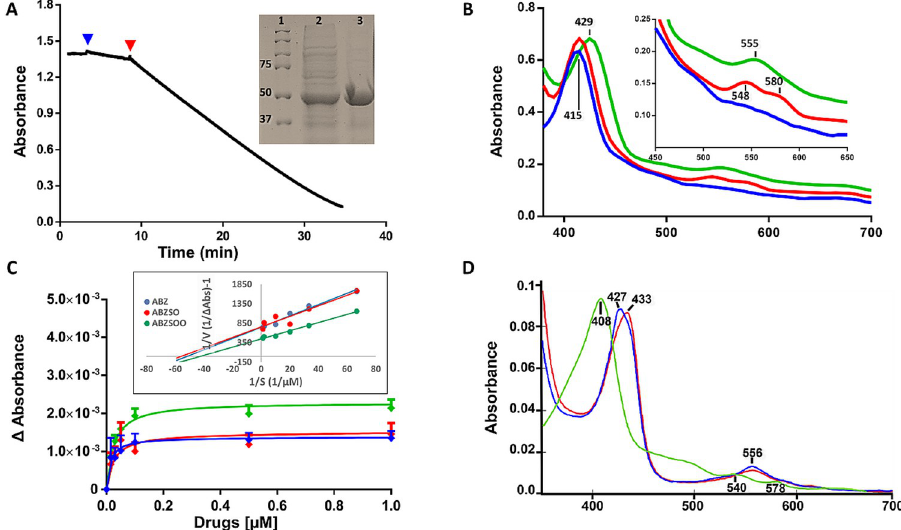
Fig 6. NADH oxidase activities of recombinant gFlHb. (A) The reaction was performed in 50 mM potassium phosphate buffer by adding 160 μ M NADH at time zero, after 0.37 μ M gFlHb (blue arrow) was added to reach a stable baseline with negligible spurious reaction. Afterwards, 1 μ M FAD (red arrow) was added to initiate the full reaction. The NADH consumption was monitored by the decrease in absorbance at 340 nm. Inset shows the purified gFlHb protein detected by 10% SDS-PAGE and Coomassie blue staining: 1) Molecular weight markers; 2) Cell lysate of E . coli overexpressing gFlHb; 3) Purified gFlHb in 53 kDa. (B) Spectral characteristics of gFlHb. Spectral traces of 6.6 μ M gFlHb in the ferric state (blue line), NADH-reduced (red line) and with ABZ (green line). (C) Saturation curves of ABZ and its metabolites under aerobiosis. Increasing concentrations of ABZ (blue), ABZSO (red) and ABZSOO (green) were added to oxidized gFlHb (0.85 μ M), and coordination was followed by monitoring the absorbance difference ( Δ A ) between the drug- complexed and the free enzyme at 416 nm. The experiments were performed at 37˚C in 50 mM potassium phosphate buffer (pH 7.5). Inset double-reciprocal plots showing a lineal behavior, used to calculate the K d values. (D) Spectral characteristics of gFlHb under anaerobiosis. Spectral traces of 0.65 μ M gFlHb in the ferric state (black), reduced with sodium dithionite (red) and with ABZ (blue). These experiments were performed at 37˚C in 0.1 M Bis-Tris (pH 6.5) and measurements were obtained using a Shimadzu UV-1900i spectrophotometer.